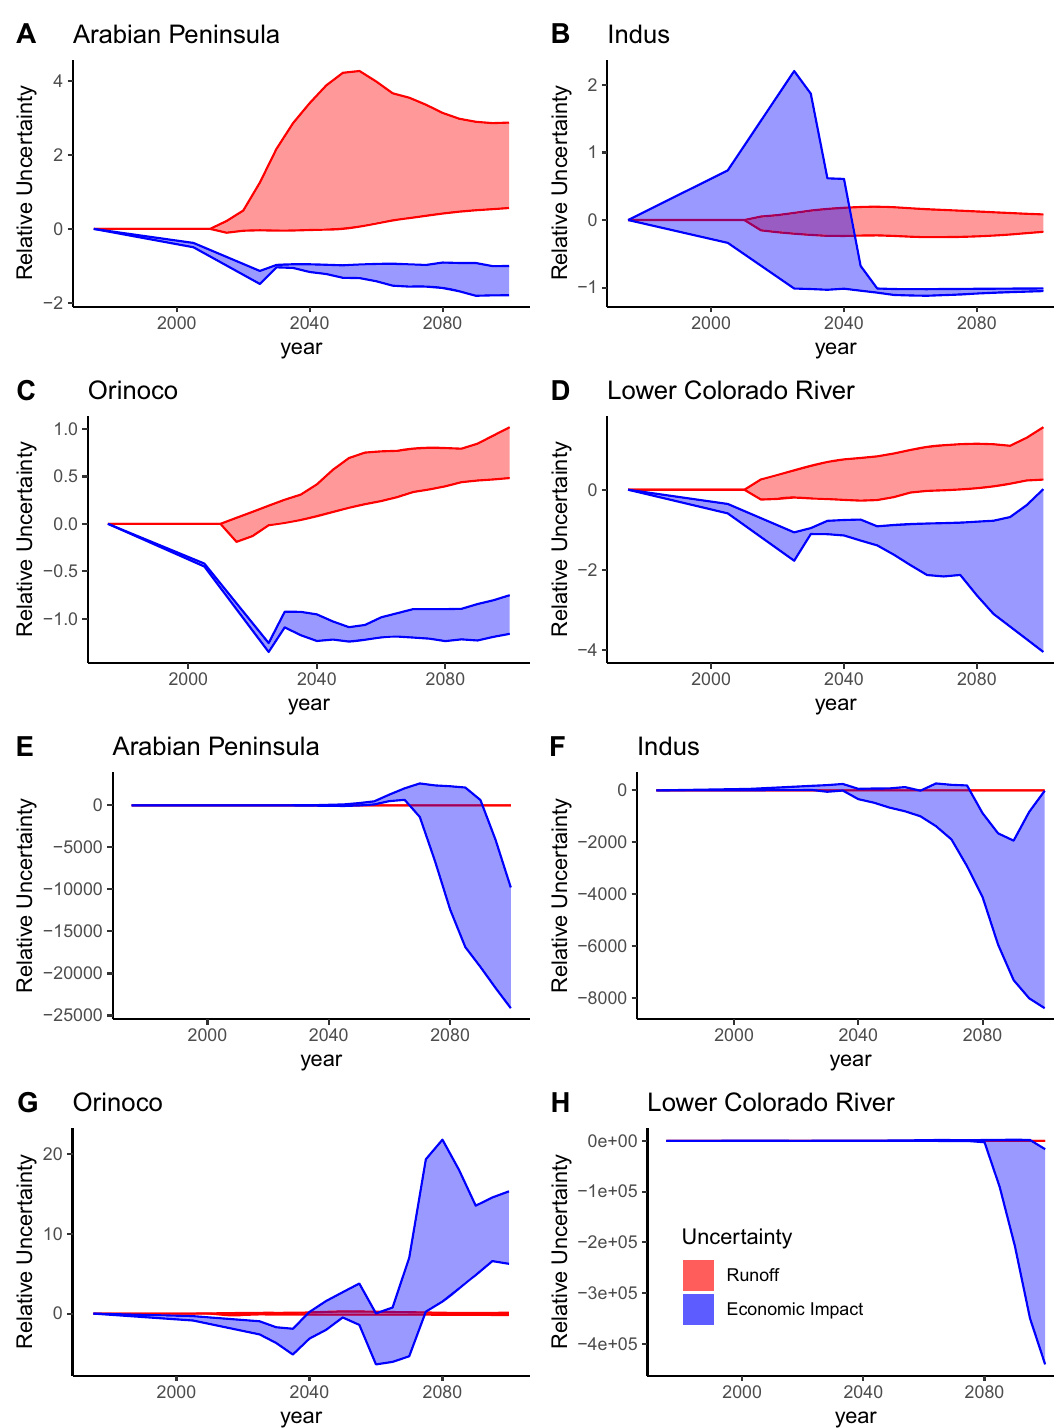
Fig. 2 Runoff and economic impact uncertainty. Uncertainty over time plots of the four chosen basins. Values are taken relative to the 2015 baseline. Uncertainty prior to 2015 is illustrative only. The scenario group shown in A – D has the lowest mean climate-induced economic impact uncertainty over time out of the 600 groups. The scenario group shown in E – H has the highest mean climate-induced economic impact uncertainty over time. In most scenarios, runoff uncertainty is ampli fi ed by the human system, leading to higher uncertainty in economic